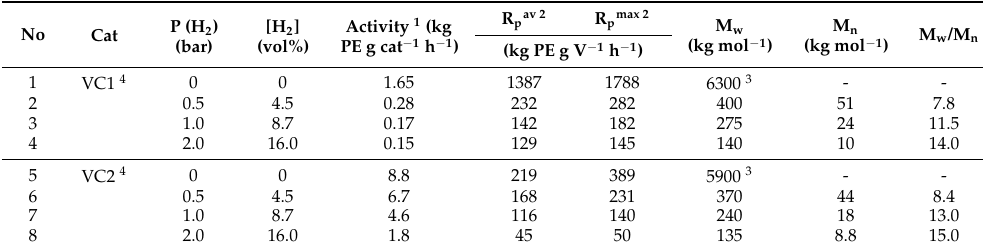
Table 1. The effect of hydrogen on the activity of VMCs with different vanadium content and molecular-weight characteristics of the produced